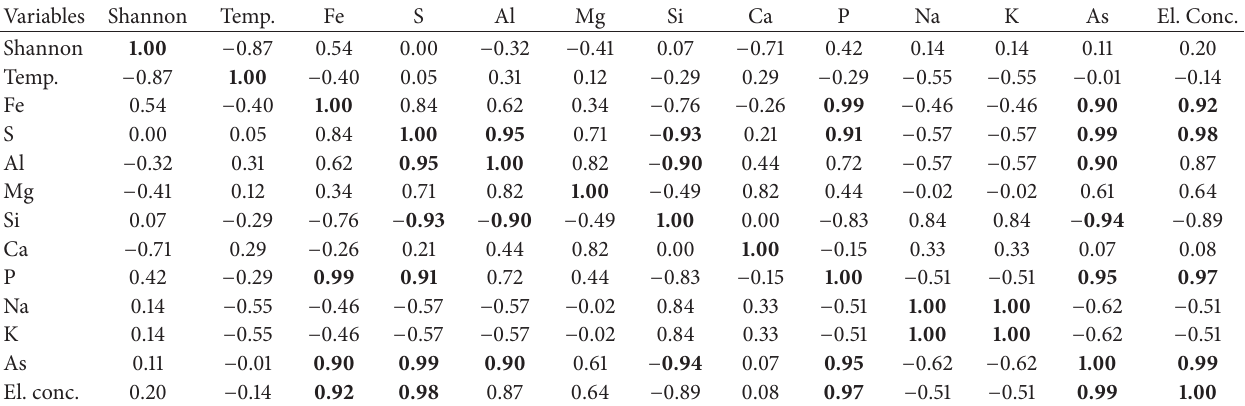
Table 4: Correlation matrix showing 𝑟 values for Pearson’s correlation.